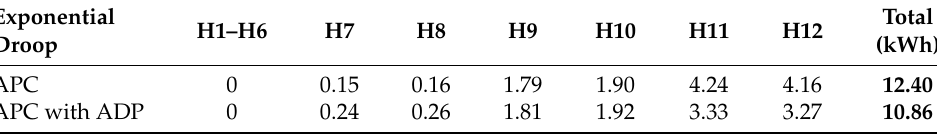
Table 4. Energy curtailed (kWh) for twelve houses with Exponential